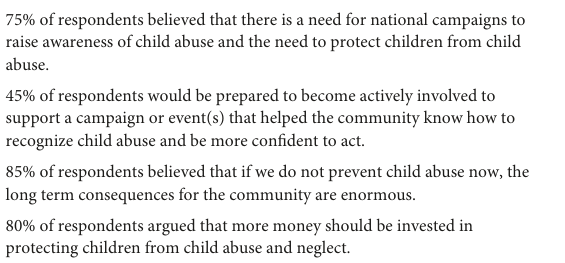
TABLE 15 Key findings.